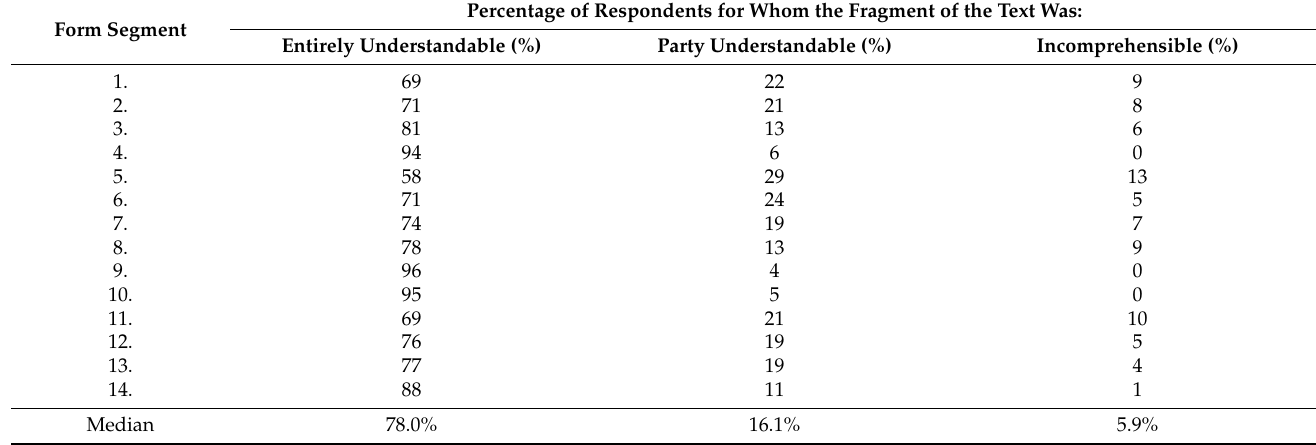
Table 3. Results of testing the informed consent (IC) form with